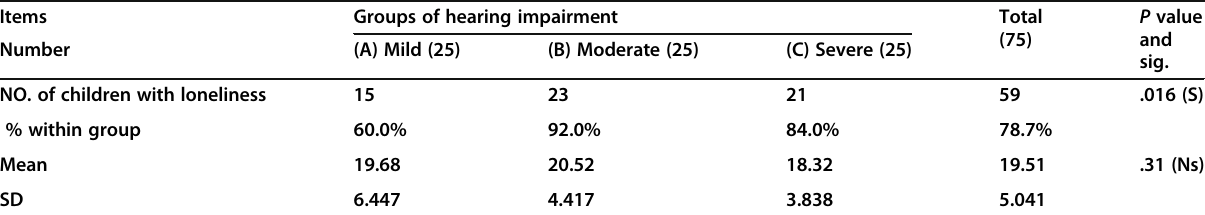
Table 3 Children ’ s Loneliness Scale (CLS) Items Groups of hearing impairment